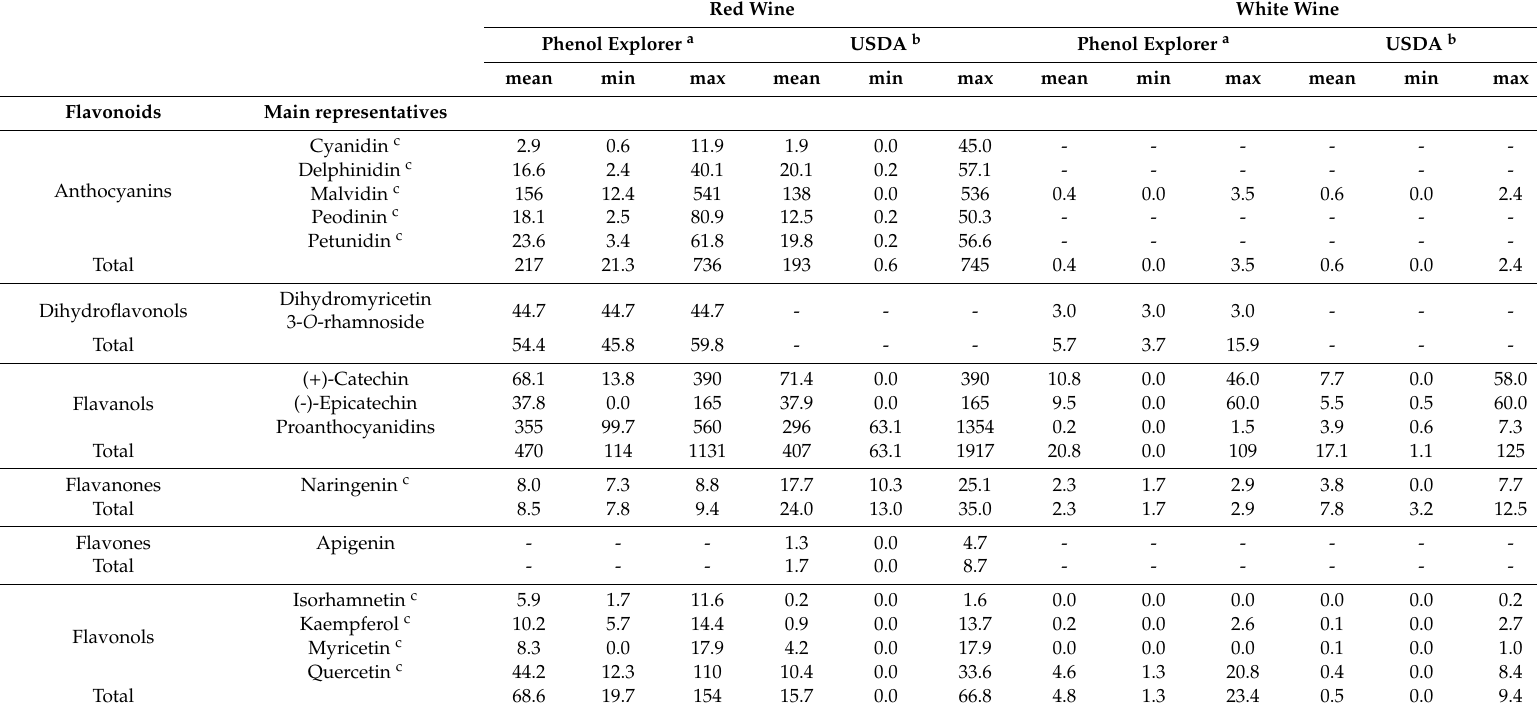
Table 3. (Poly)phenol contents in red and white